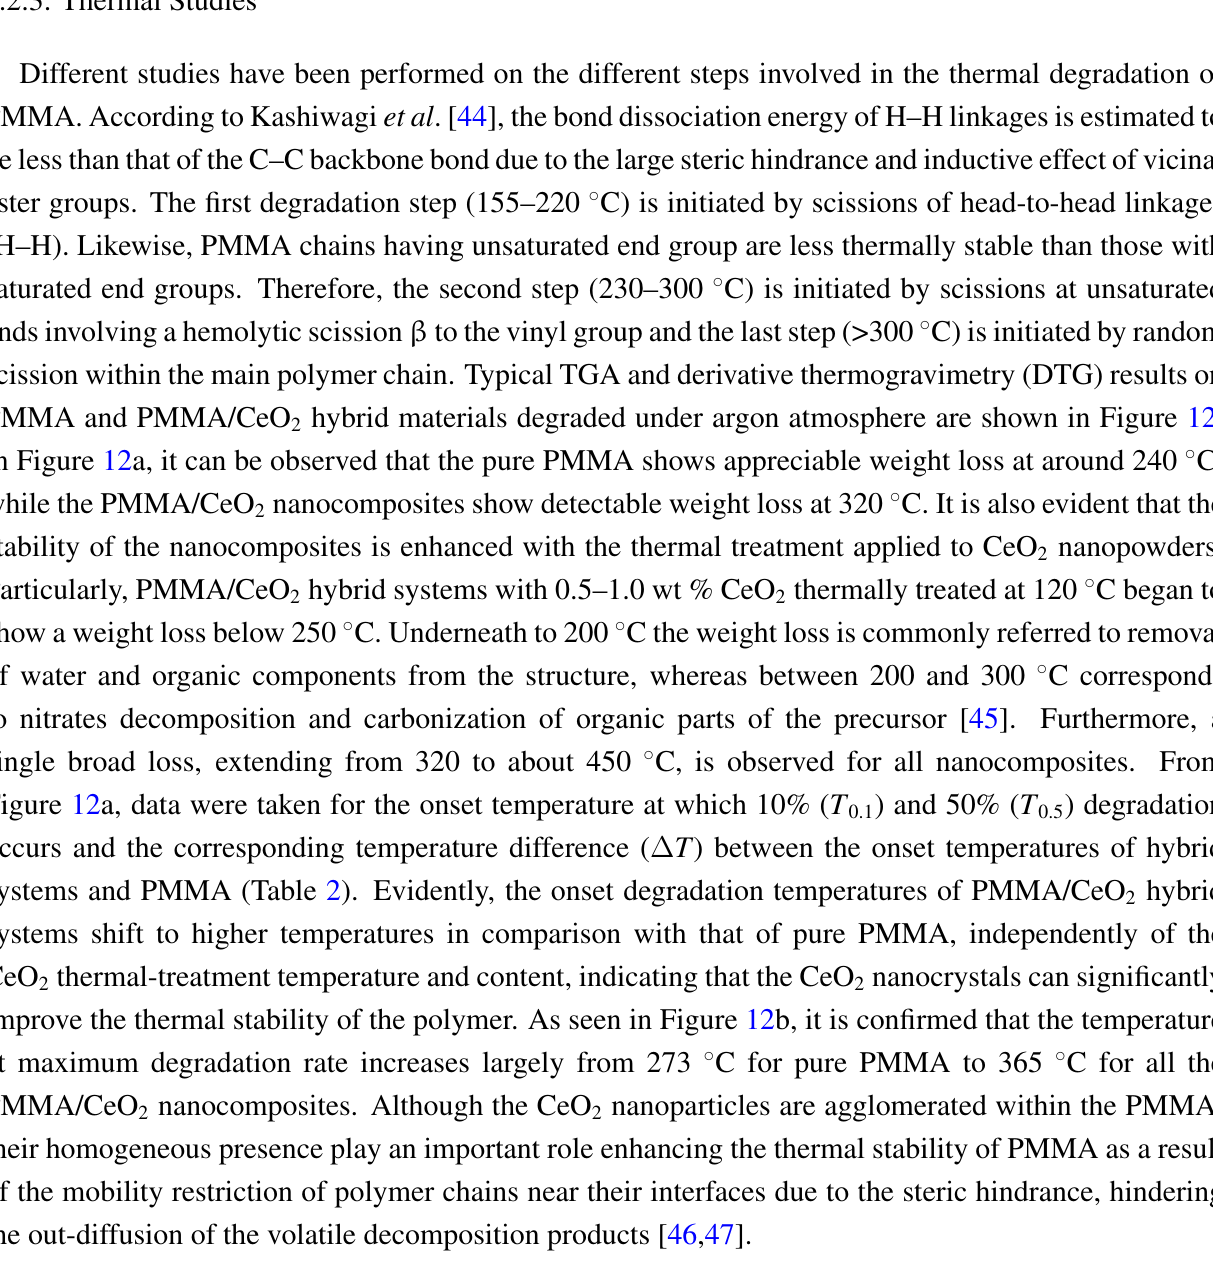
Figure 11. Photographs of the pure PMMA and PMMA/CeO 2 hybrid systems.